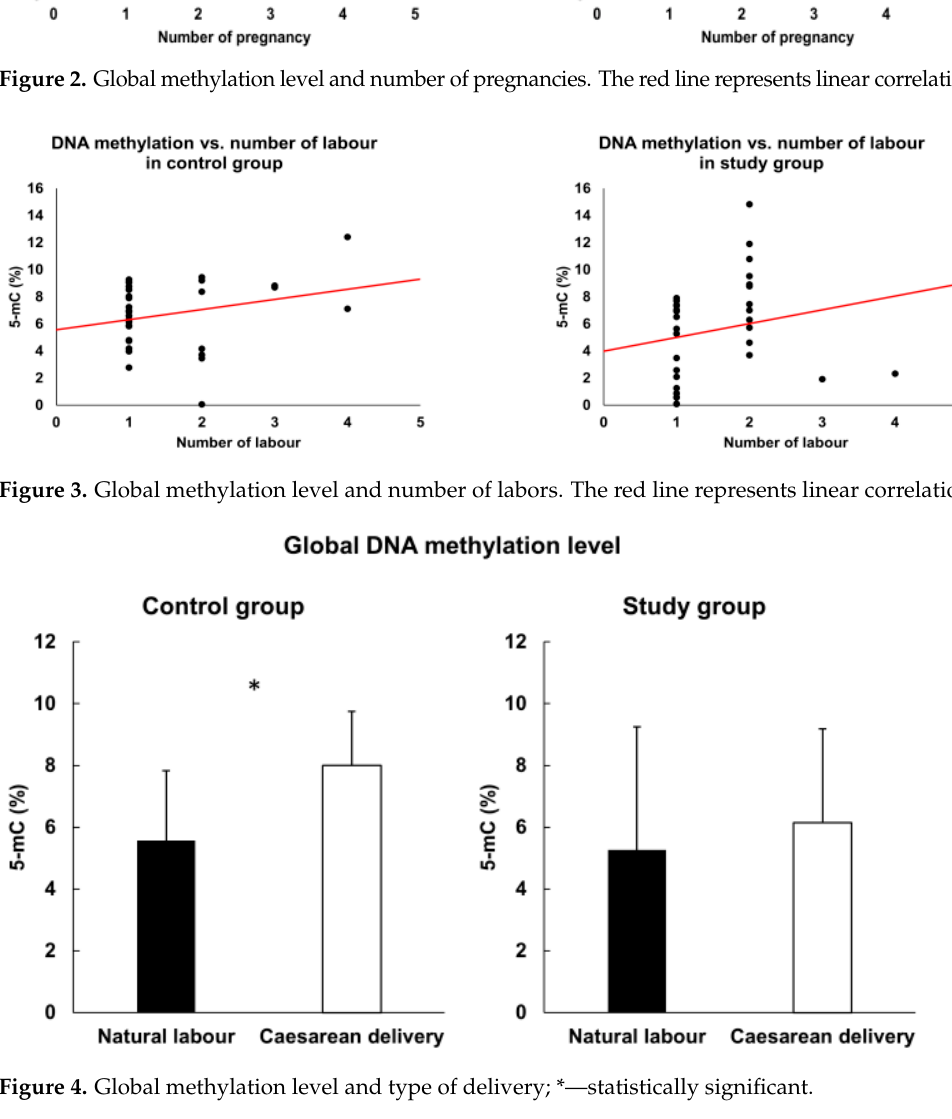
Figure 5. Global methylation level and fever episodes; *—statistically significant. Figure 6. Global methylation level and varicella infection in the total group; *—statistically signifi ‐ cant.